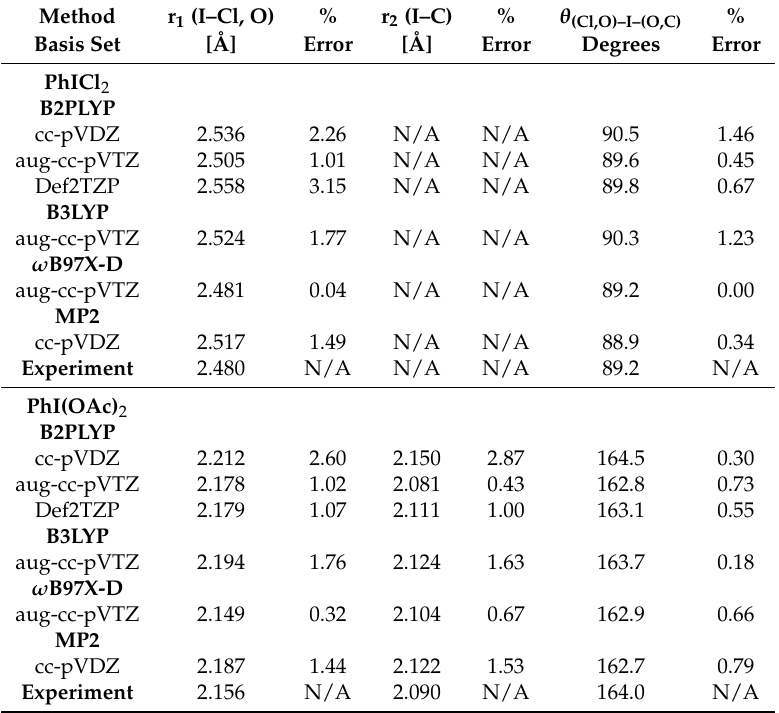
Table A2. Calculated and experimental bond lengths and bond angles for PhICl 2 and PhI(OAc) 2 showing B2PLYP/aug-cc-pVTZ and ω B97X-D/aug-cc-pVTZ levels of theory giving closest agreement with the experiment [18,63].